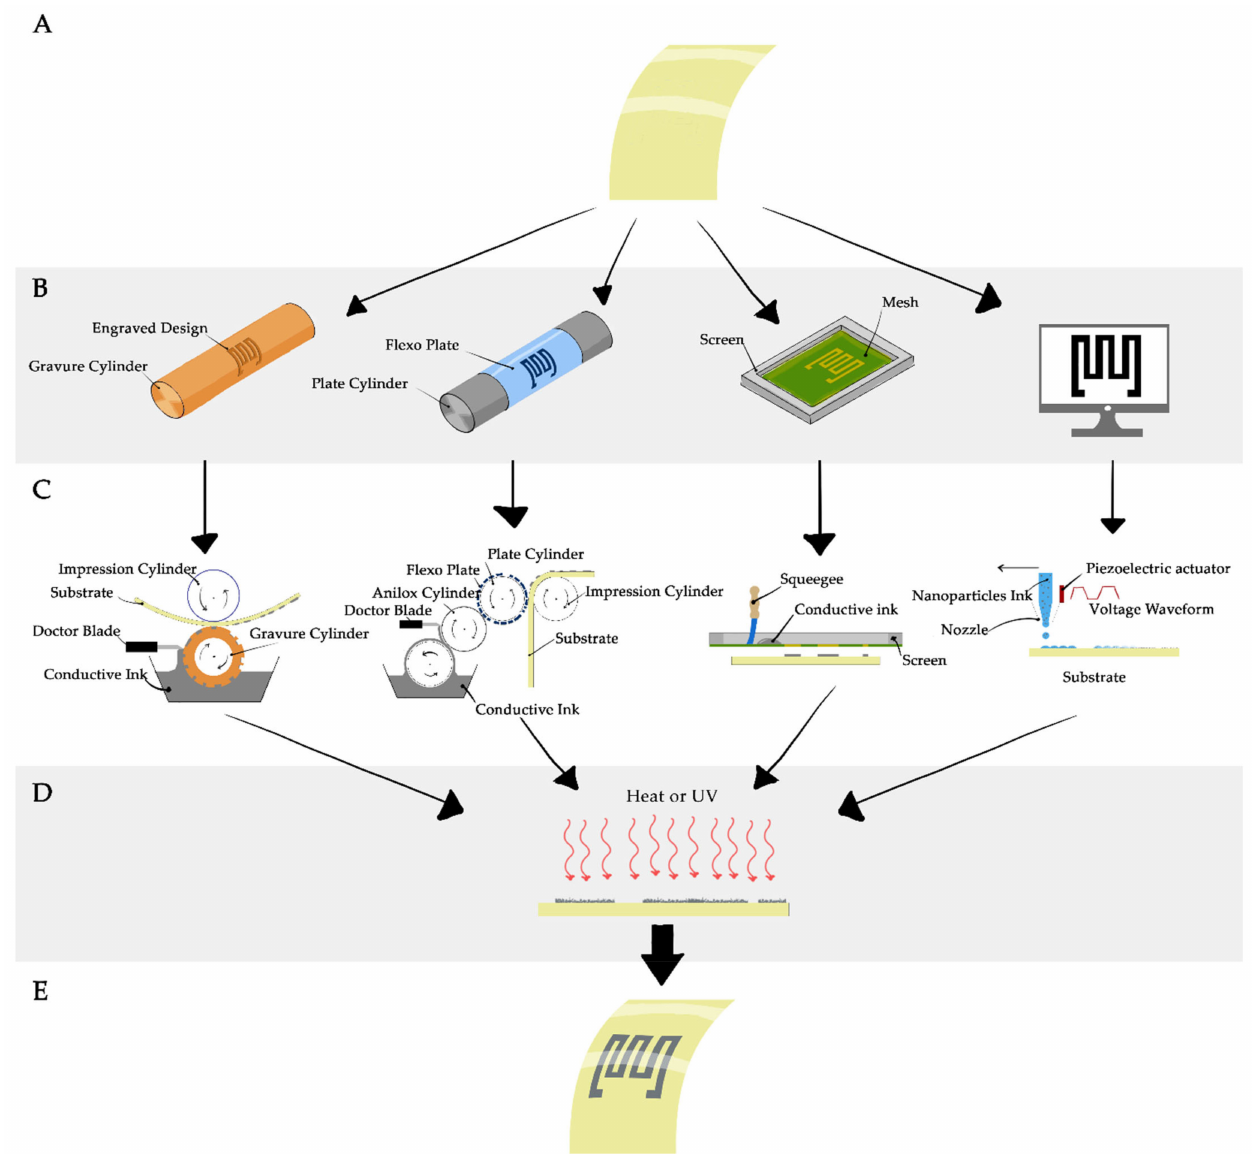
Figure 3. A summary of the printing methods described above (gravure, flexographic, screen, and inkjet printing). Step ( A ) represents the substrate preparation, step ( B ) shows the feature realization needed to transfer the design from the carrier, step ( C ) illustrates the process of different printing methods, step ( D ) shows the sintering process were solvents evaporate and the sold components of the ink remain, and Step ( E ) shows the finished printed sensor. Steps ( A , D , E ) are usually common in all printing